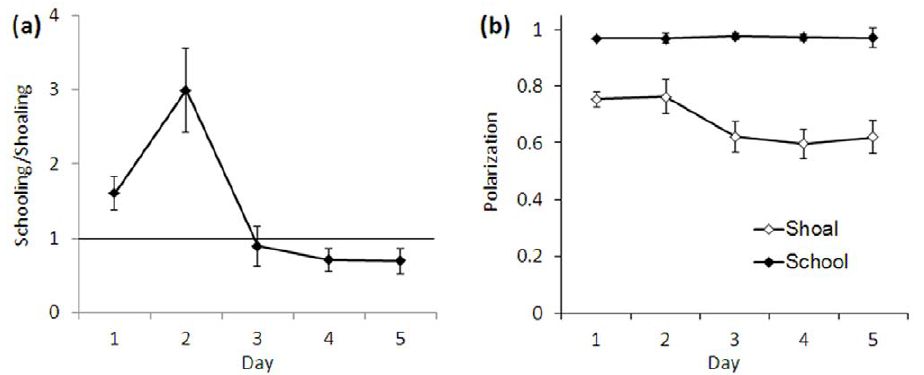
Figure 3. Ratio of the mean time spent schooling to shoaling (a) and mean modes of polarization distribution components (b) by testing day in Experiment 1. Unimodal data distributions were excluded. Error bars represent 6 SEM. The spike in time spent schooling on day 2 (a) is attributable to a few outlier sessions.